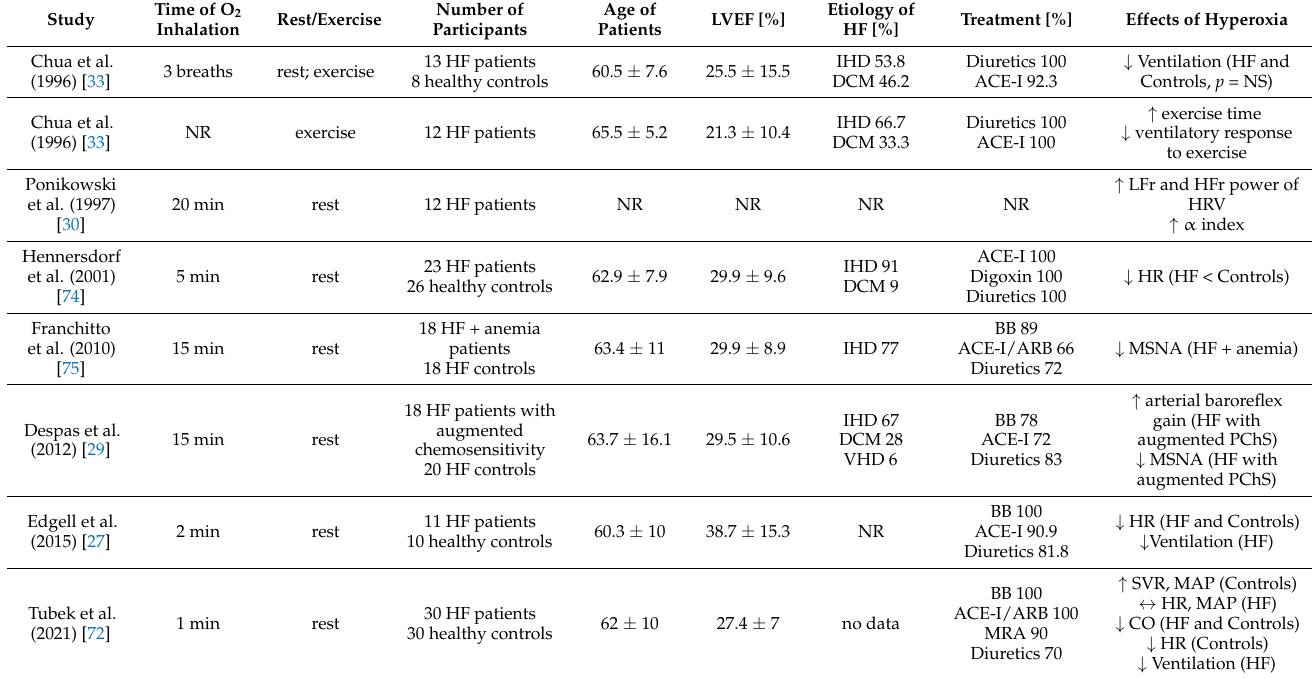
Table 2. Comparison of clinical studies using hyperoxia in HF